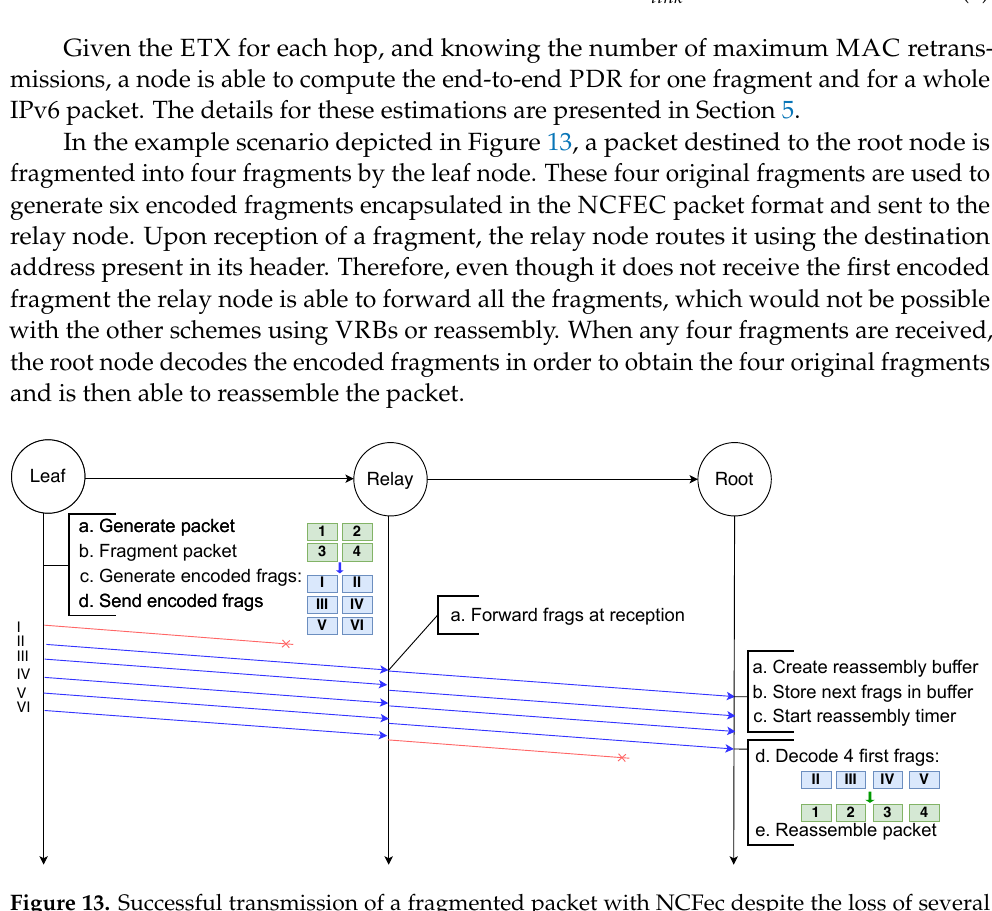
Figure 13. Successful transmission of a fragmented packet with NCFec despite the loss of several